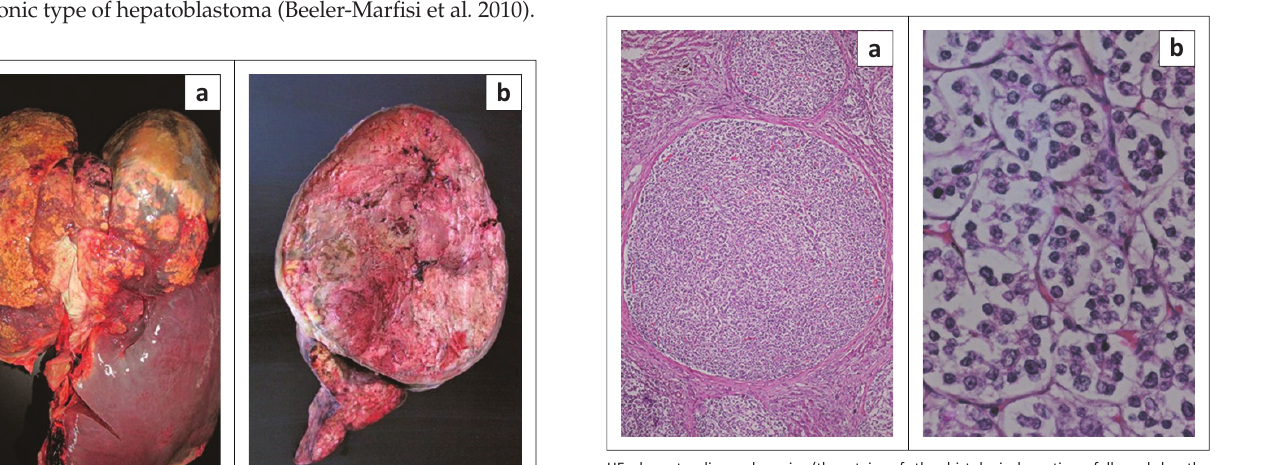
FIGURE 2: Post-mortem gross liver findings in a 3-year-old Thoroughbred colt that suffered from fatigue fractures (Figure 1) as well as consistent erythrocytosis. (a) Full view of the liver demonstrating a large round mass in the left medial lobe and multifocal masses in the left lateral lobe. The right liver lobe has normal appearance. (b) A transverse cut through the mass in the left medial liver lobe.